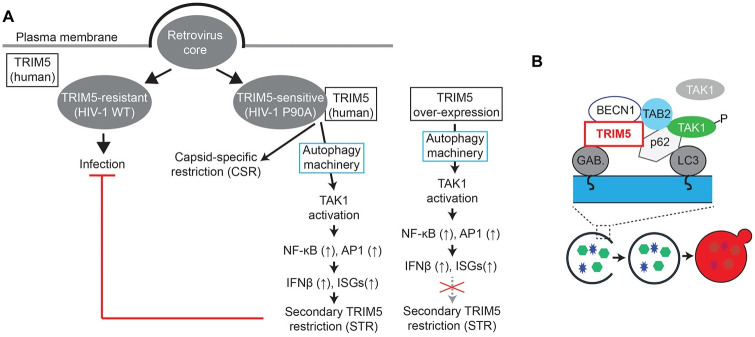
Model of how autophagy contributes to TRIM5-TAK1 signaling and the establishment of an antiviral state.(A) TRIM5-sensitive retroviral cores are recognized by TRIM5, leading to direct capsid-specific restriction and triggering a signal transduction cascade that results in the establishment of a general antiviral state. While TRIM5 over-expression can mimic some aspects of viral recognition by TRIM5, it is insufficient to enable viral restriction by TRIM5-resistant viruses. (B) Autophagy-dependent assembly of TRIM5-TAK1 complexes that result in TAK1 activation by TRIM5. The various protein-protein interactions depicted are based on findings in this work and in previous reports. Autophagic degradation of negative regulators of TRIM5-TAK1 signaling may also contribute.